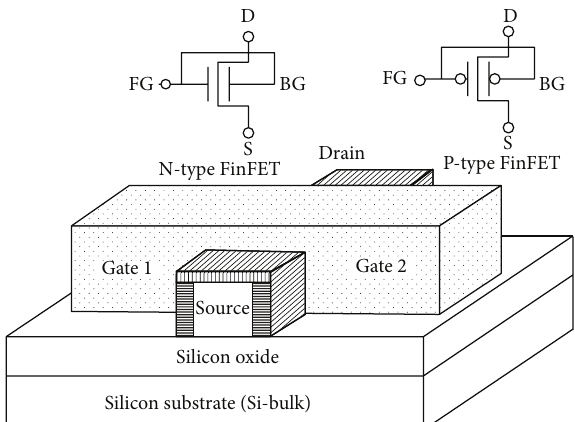
Figure 3: Basic structure of FinFET (double gate structure).